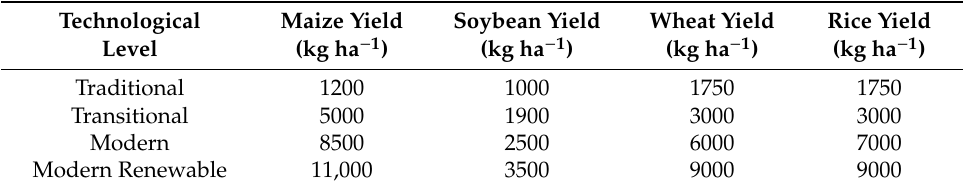
Figure 5. Maize Yields for Selected Countries. Data: FAO [6]. Table 5. Crop yields per technological level.